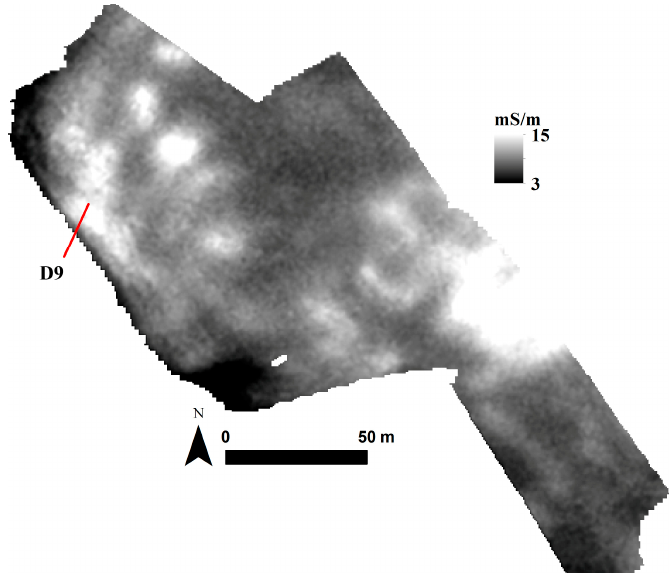
Figure 16. Electrical conductivity data from Perdika 2.